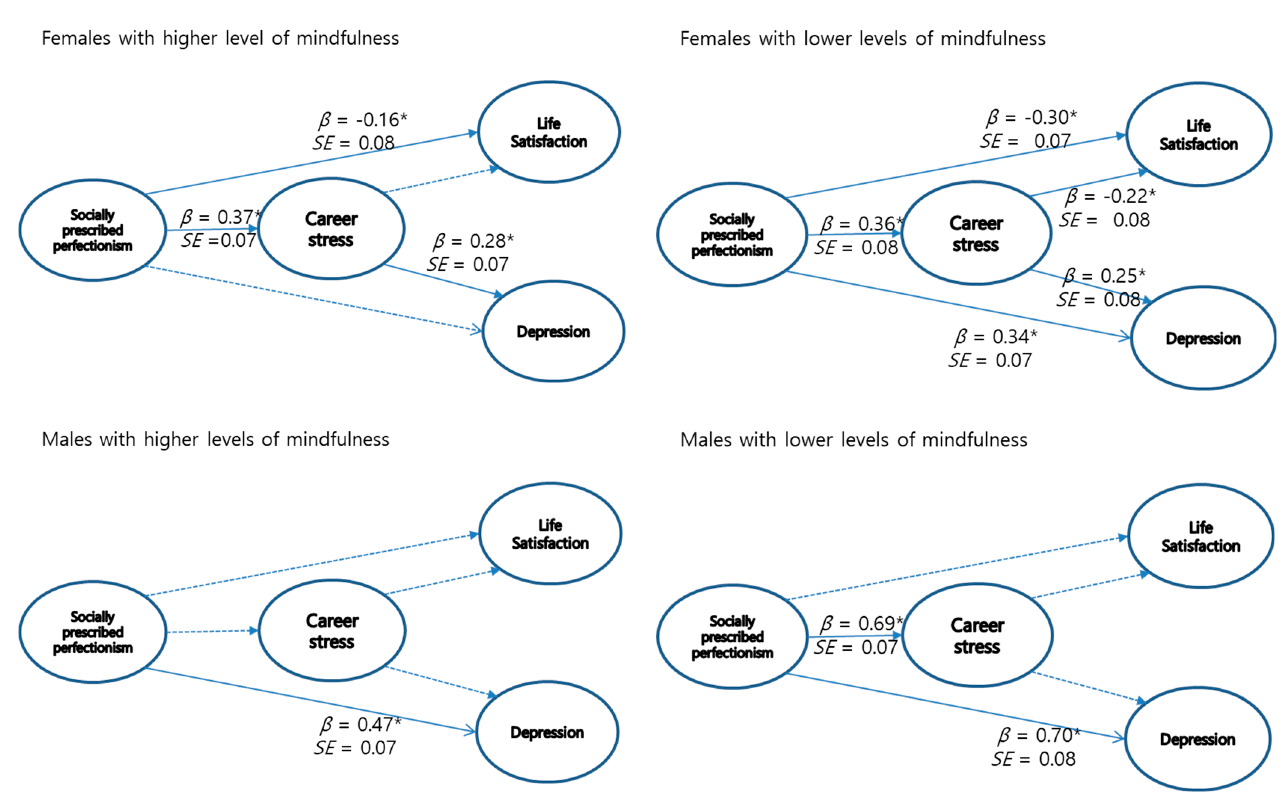
Figure 1. Final model estimation with standardized beta weight ( SE ). Note . * p < 0.05; significant path coefficients are shown in bold line; dotted line = non-significant.